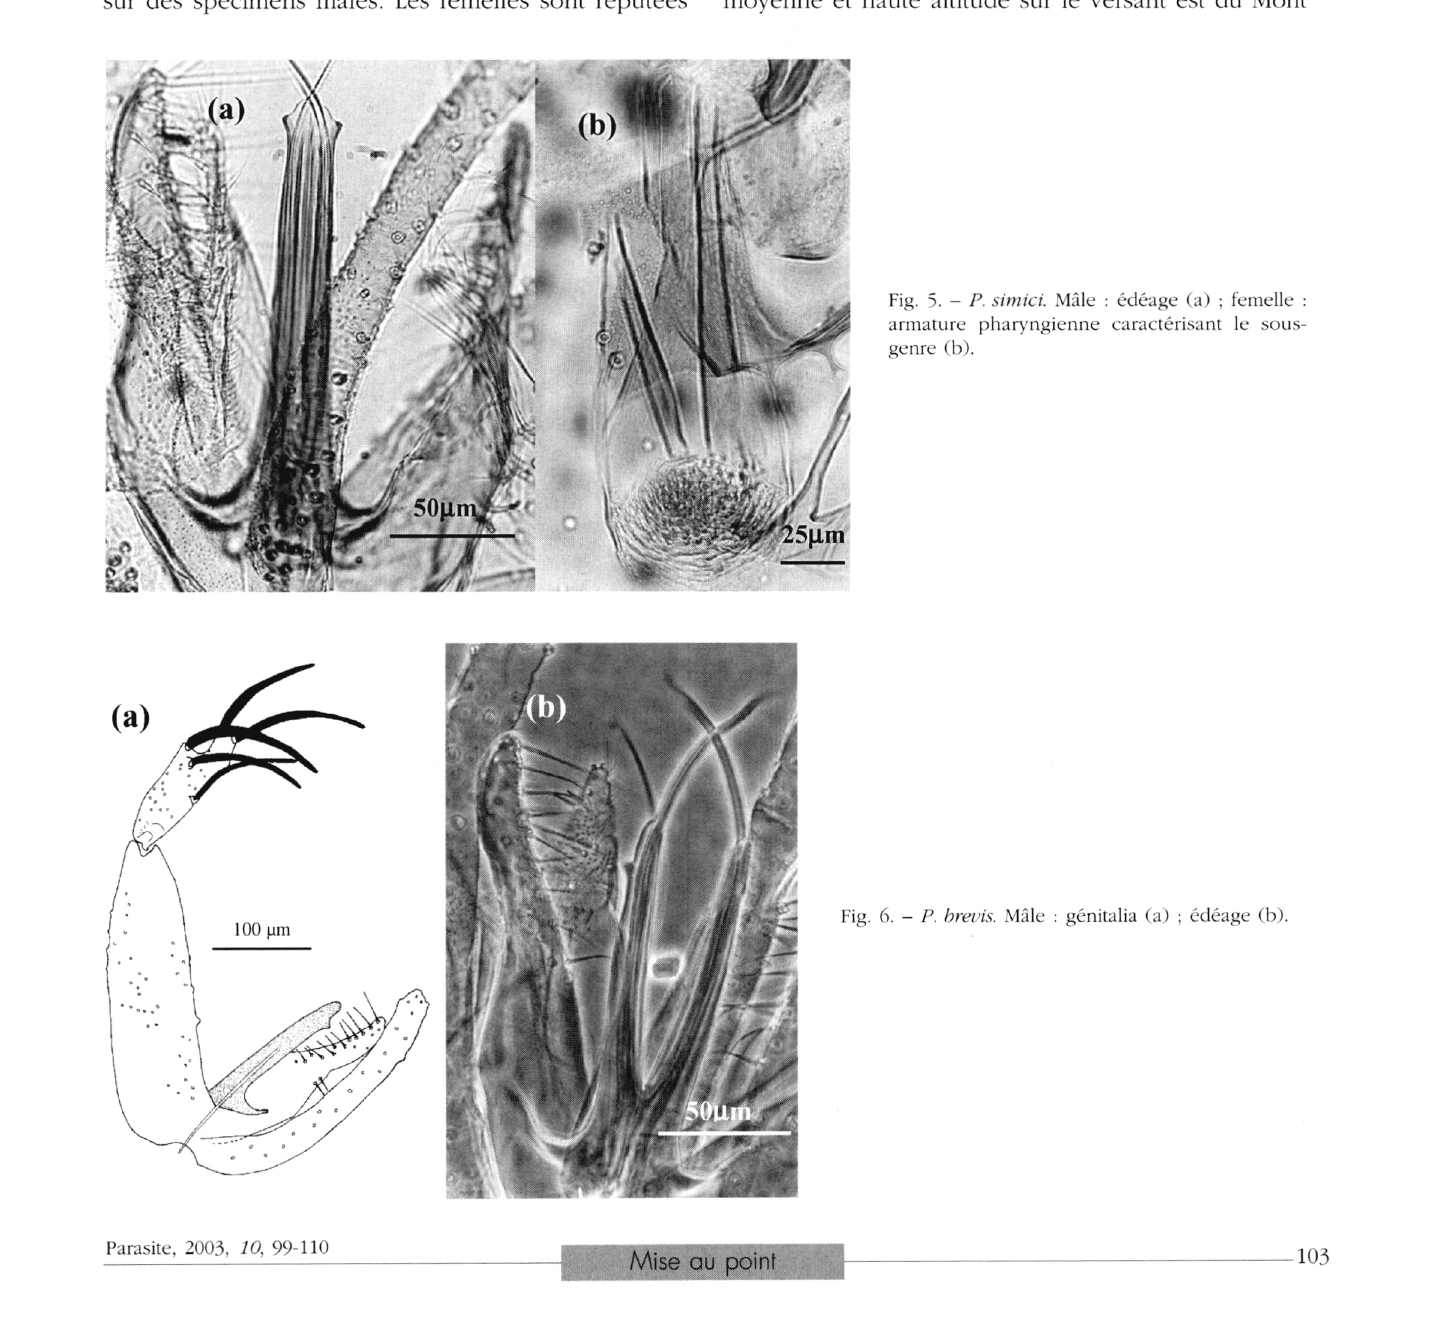
Fig. 6. - P. brevis. Mâle : génitalia (a) ; édéage